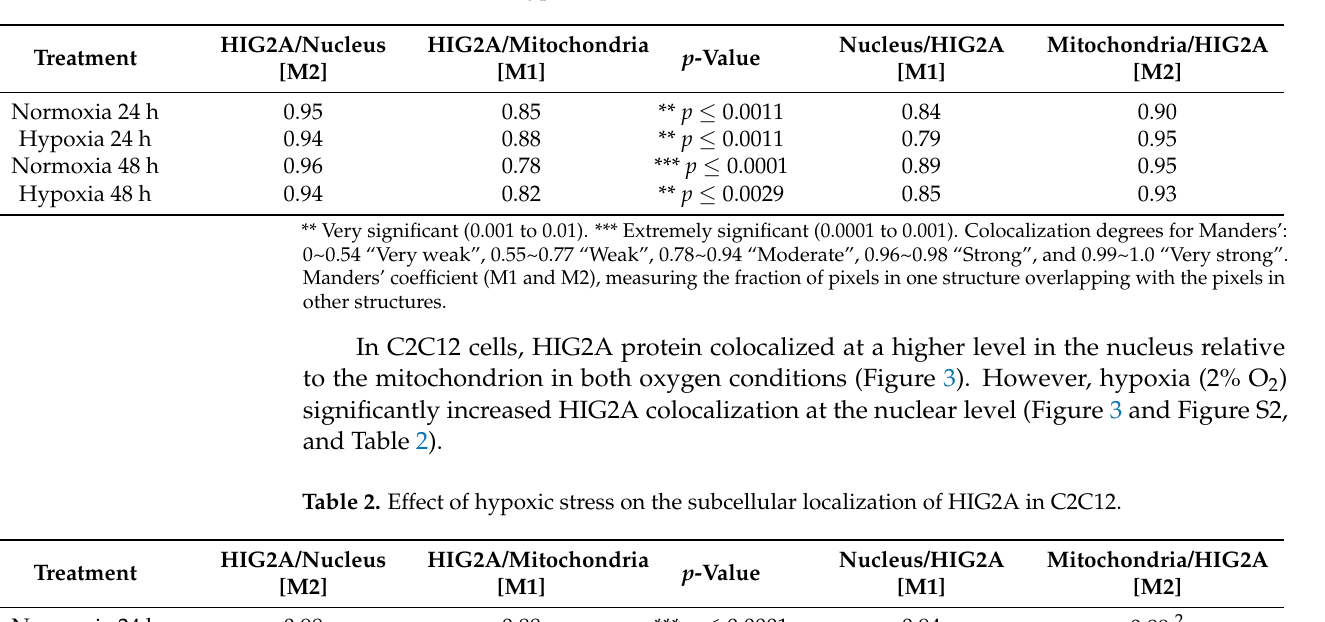
Table 1. The effect of hypoxic stress on the subcellular localization of HIG2A in HEK293.